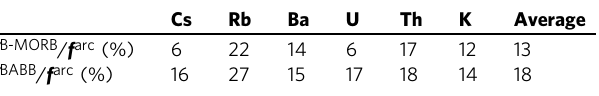
Table 1 Estimated slab fl uxes for Cs, Rb, Ba, U, Th, and K in MORB and BABB relative to the global output at arcs.